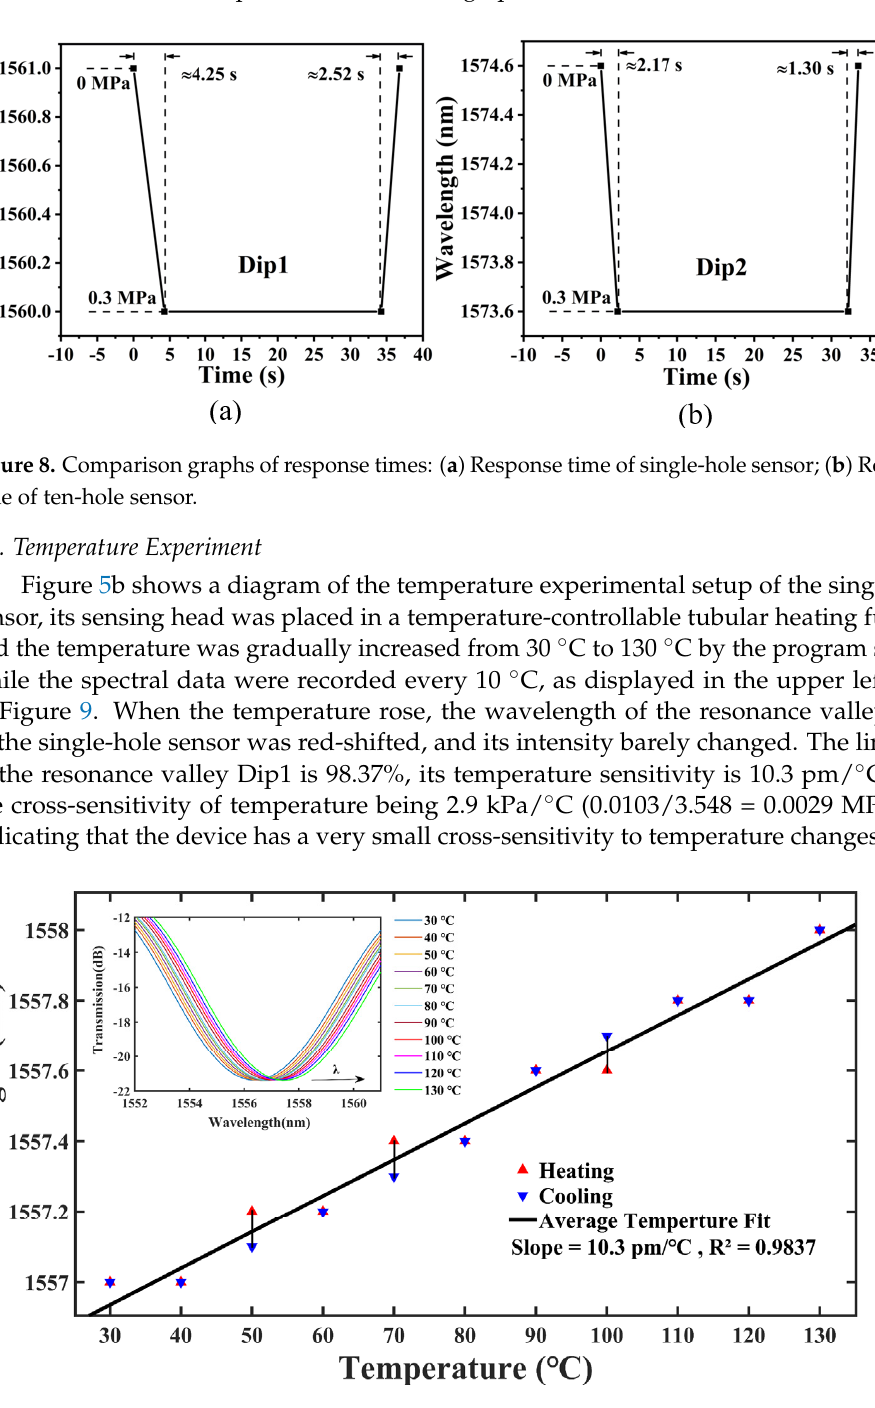
Figure 9. Spectral drift and linear fit of temperature sensitivity.